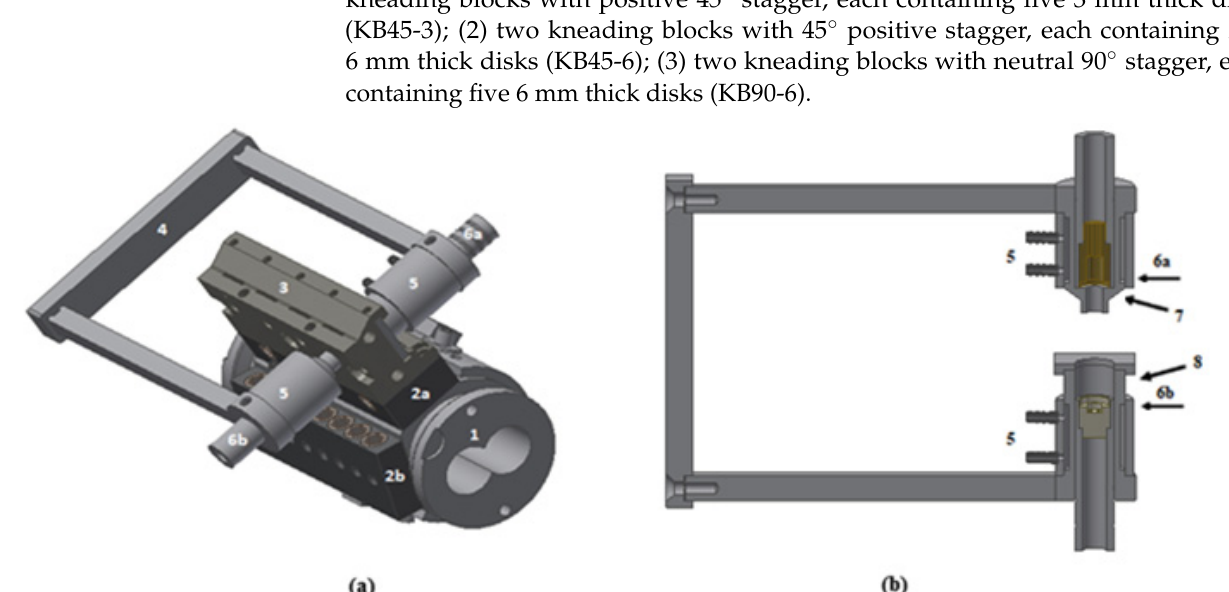
Figure 1. ( a ) Experimental set-up: modified barrel segment (1) with two axial rows of sampling de- vices (2a, 2b); multi-slit die (3); sliding optical detector with a C-shaped support (4); water-cooling system (5); light source (6a) and receptor (6b) for optical measurements and ( b ) Optical detector system: LED (6a) with a polarizer (7) and two LDRs (6b) with a polarizing filter (8).